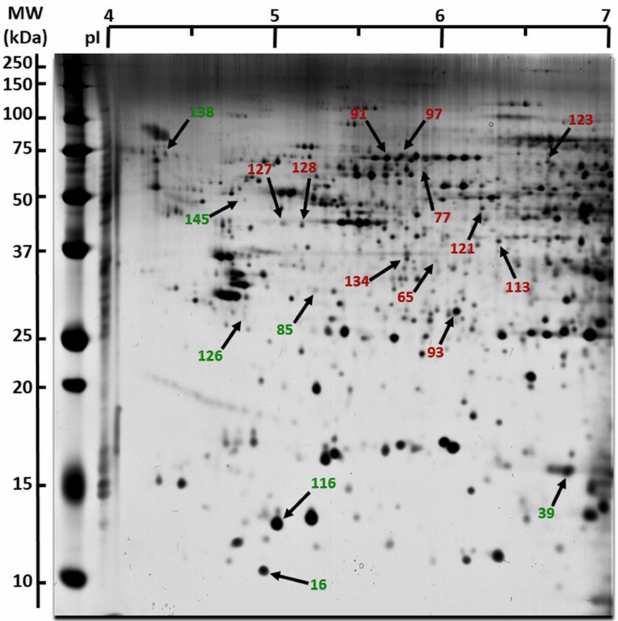
Figure 3. Proteome changes following bystander effect. Whole cell extracts from T/C-28A2 bystander cells receiving the conditioned medium of (1) low-dose irradiated chondrosarcoma cells or (2) non- irradiated chondrosarcoma cells were analyzed and compared by 2DE. One representative gel of (1) is shown. A total of 250 micrograms proteins were separated using 18-cm pH 4-7 pI range strips for the first dimension, and 12% acrylamide gels for the second dimension. Differentially expressed spots were delineated either in green (induced in (1) cells) or in red (repressed in (1)